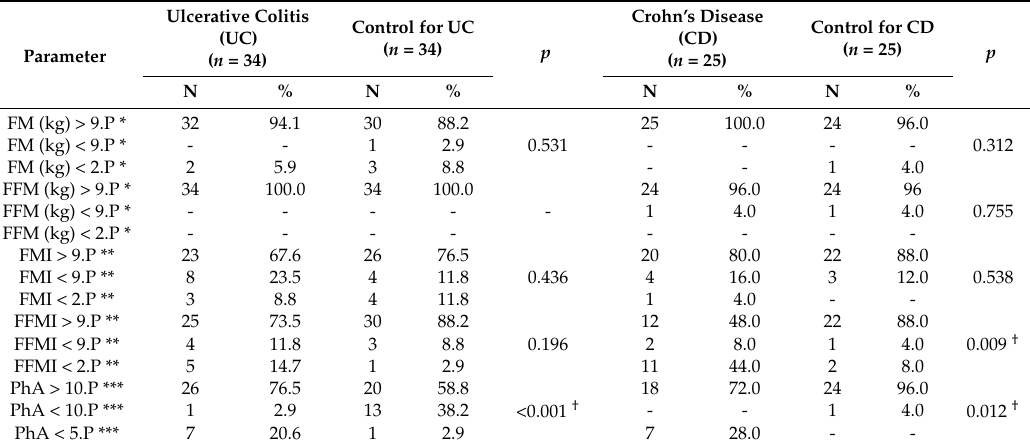
Table 5. BIA results in UC vs. CD participants according to